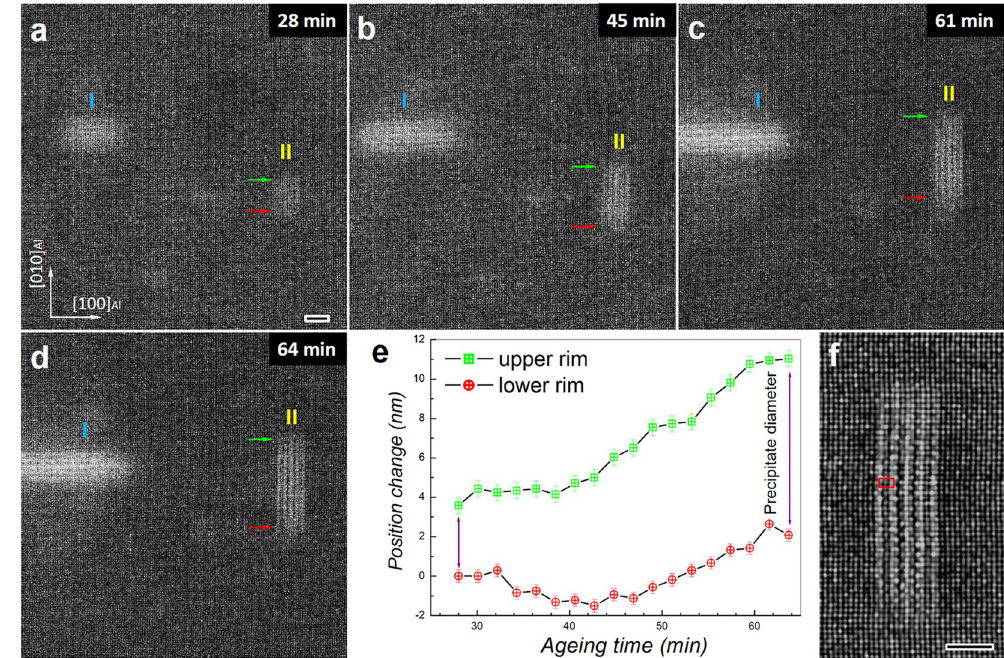
Figure 2. The growth of an initial-stage precipitate. Snapshots taken from HR-STEM Movie S5 obtained after heating the quenched Al-Cu alloy at 160 °C for ( a ) 28 min, ( b ) 45 min, ( c ) 61 min, and ( d ) 64 min. The blue arrow and red arrow point to the upper rim and lower rim, respectively. ( e ) The change of the positions of upper rim and lower rim of this precipitate. ( f ) The atomic-scale ADF-STEM image of the precipitate in ( d ). Scale bars ( a – d ) 2 nm, ( f ) 2